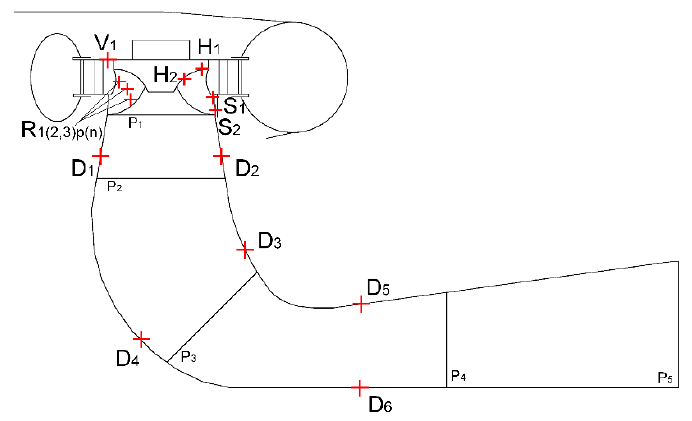
Figure 3. Location of the monitoring points and sections.